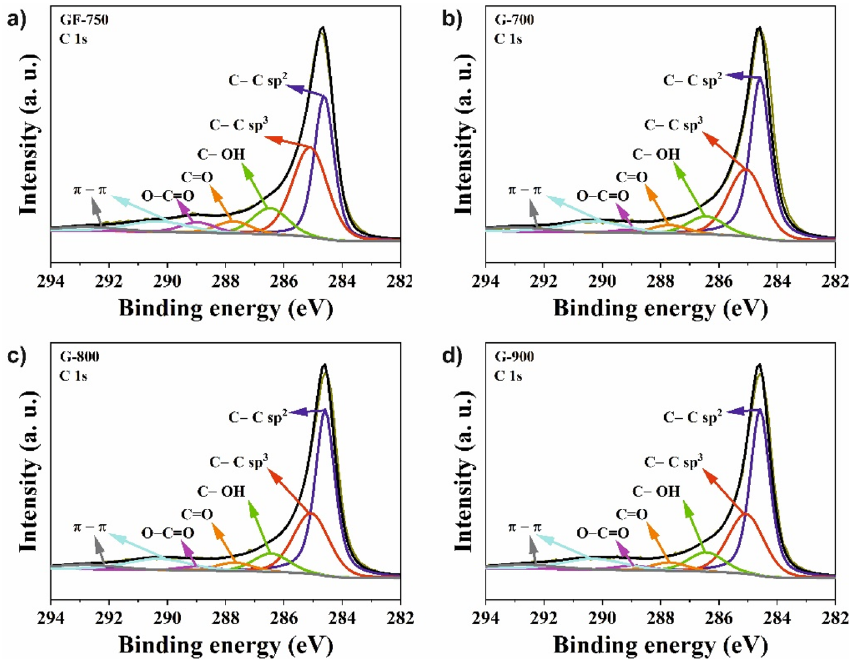
Figure 6. High-resolution X-ray photoelectron spectra for C1s of all investigated samples: ( a ) C1s of GF-750, ( b ) C1s of G-700, ( c ) C1s of G-800, and ( d ) C1s of